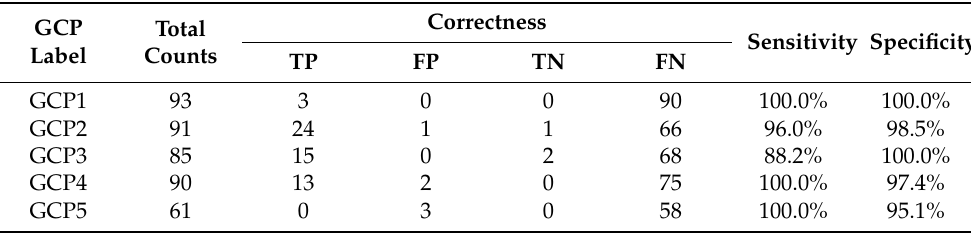
Table 4. The accuracy evaluation of the adjusted boxplot.